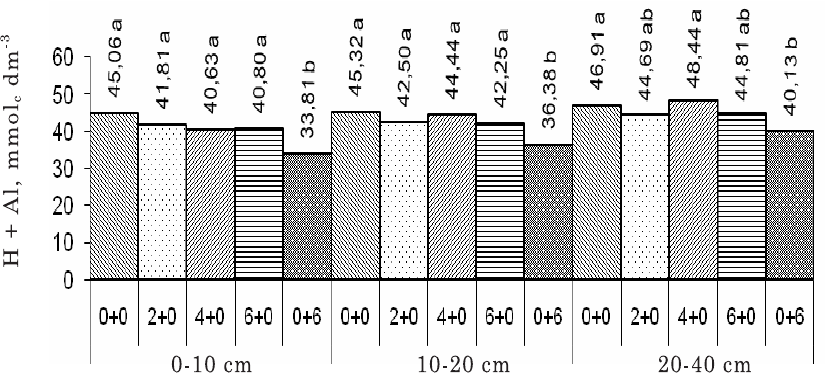
Figura 4. Teores de H + Al no solo para a interação Tratamentos x Profundidades. Teores acompanhados de mesma letra, dentro de profundidade, não diferem estatisticamente entre si pelo teste de